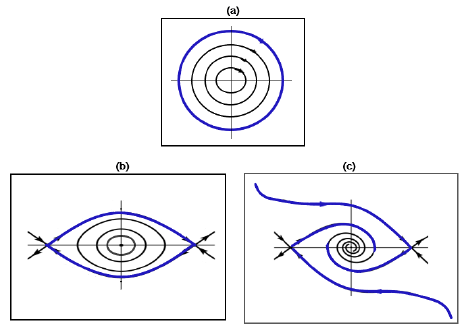
Figure 1. Illustration of the basic principles of open dynamical systems. In (a), we obverse a basic process depicting the phase portrait for a harmonic oscillator happening in a plane and where the only fixed point is the origin and the circles represent the other trajectories. In (b), we obverse another basic process depicting the phase portrait of undamped pendulum happening in a cylinder and where trajectories are closed curves with some going around the origin and other wrapping around the cylinder. Lastly, in (c), we obverse a process depicting phase portrait for a damped pendulum with the difference that the origin has become an attracting fixed